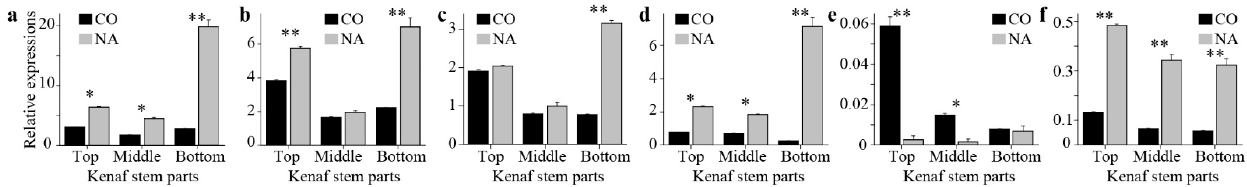
Figure 8. Relative expression levels of several unigenes. The relative expressions of PAL ( a ), C4 H ( b ), CCR ( c ), F5 H ( d ), YUC ( e ), and AAO3 ( f ) genes from the three kenaf stems at the normal (CO) and stress (NA) conditions were respectively displayed. The GAPDH gene (Cluster-20656.100749) was selected as reference control for expression calculation. Primers and representative IDs for these six unigenes were listed in Table S5. PAL , phenylalanine ammonia lyase; C4 H , cinnamate 4 hydroxylase; CCR , cinnamoyl-CoA reductase; F5 H , ferulate 5 hydroxylase; YUC , flavin monooxygenases YUCCA ; AAO , aldehyde oxidases. The * or ** indicate the significant difference at threshold of 0.05 or 0.01 under Student’s t-test, respectively.